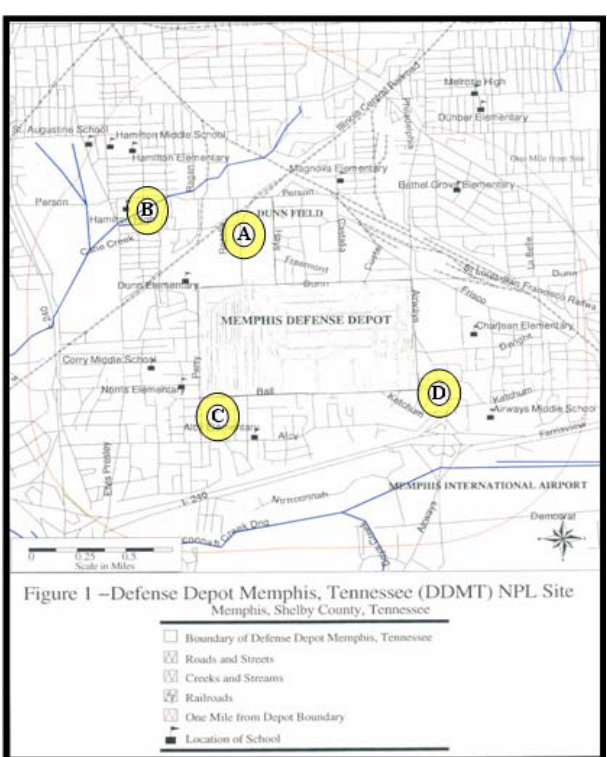
Figure 3: Map of DDMT and Sampling Sites. A = 1835 Rozelle Street, B = Cane Creek, C = Ball & Mullen, D = Stormwater Runoff